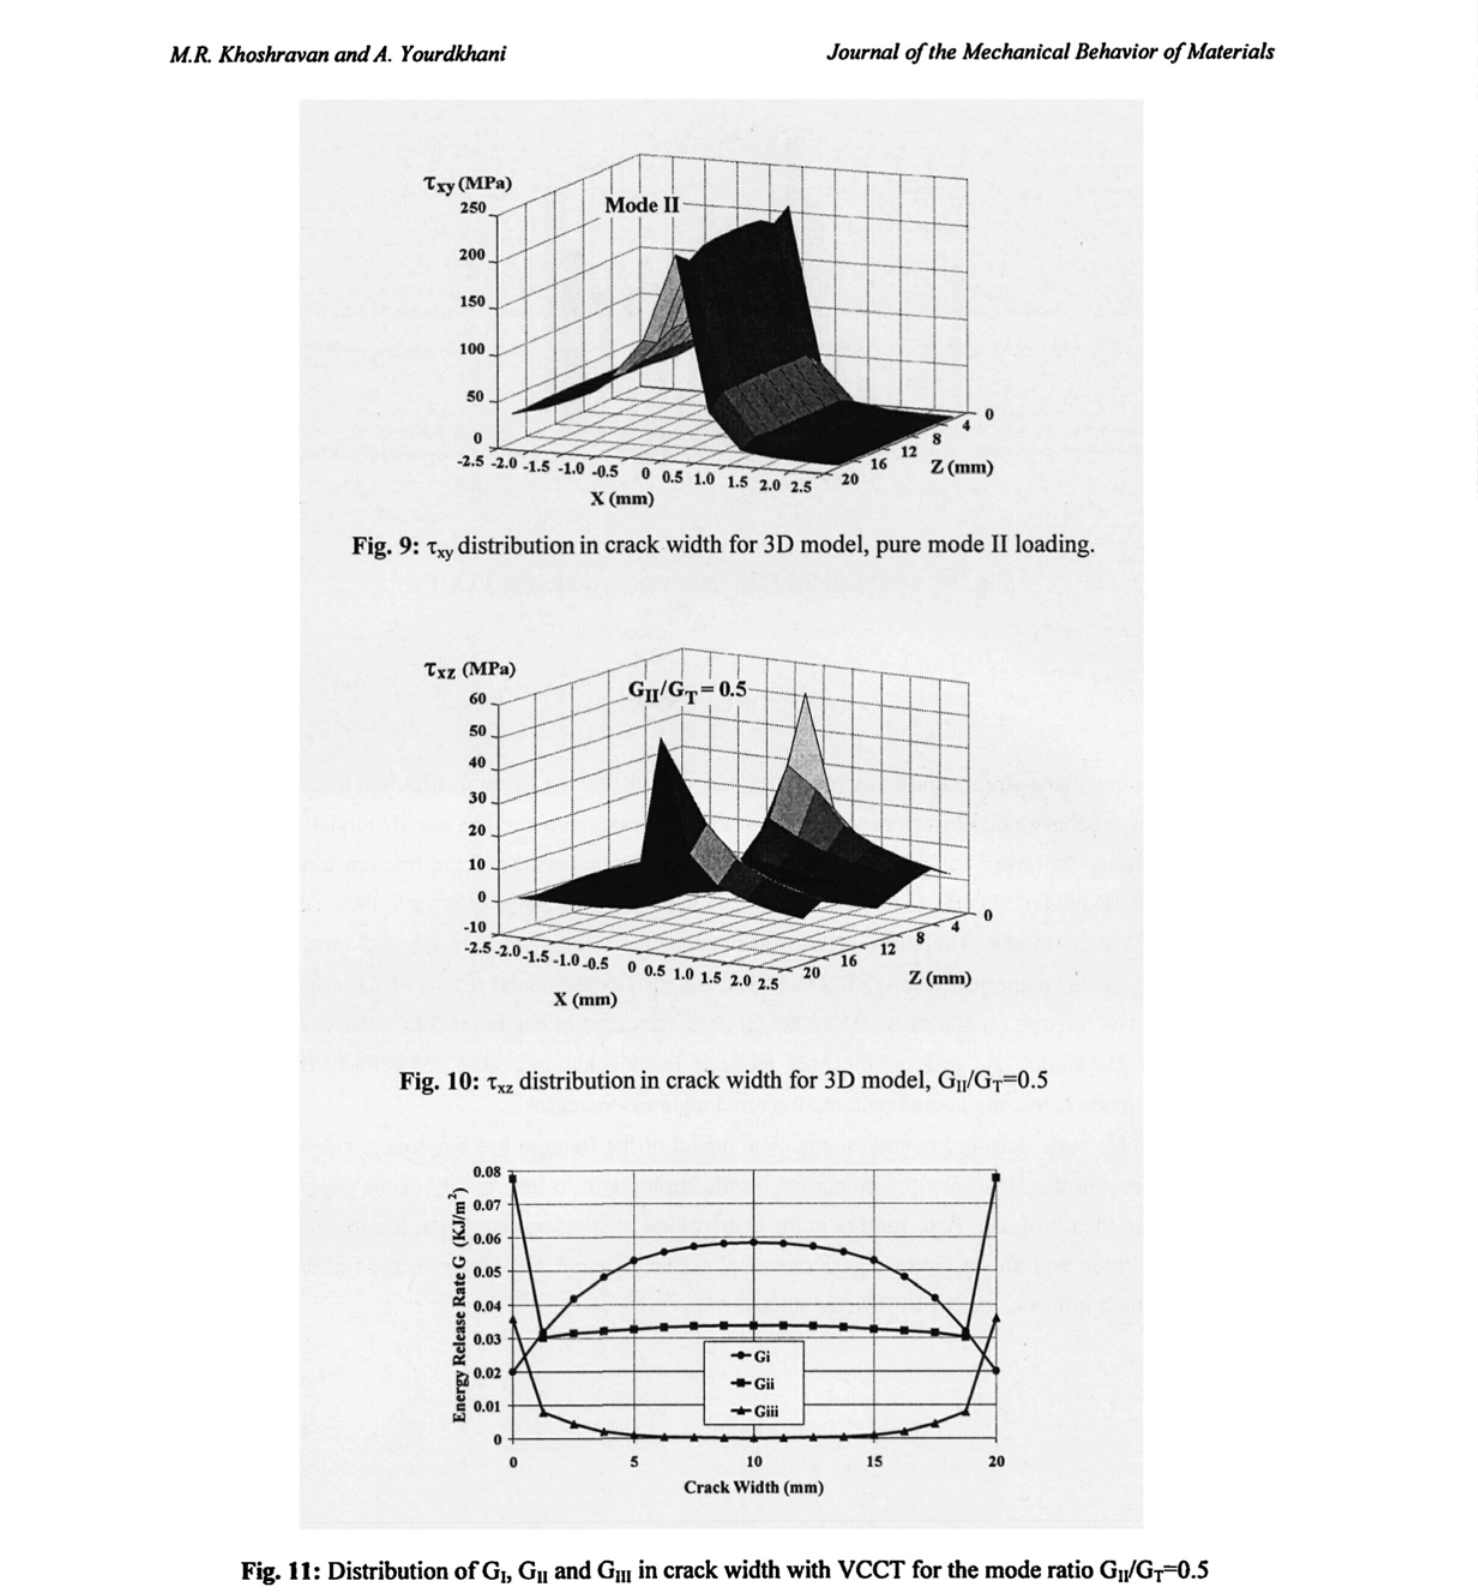
Fig. 11: Distribution of G